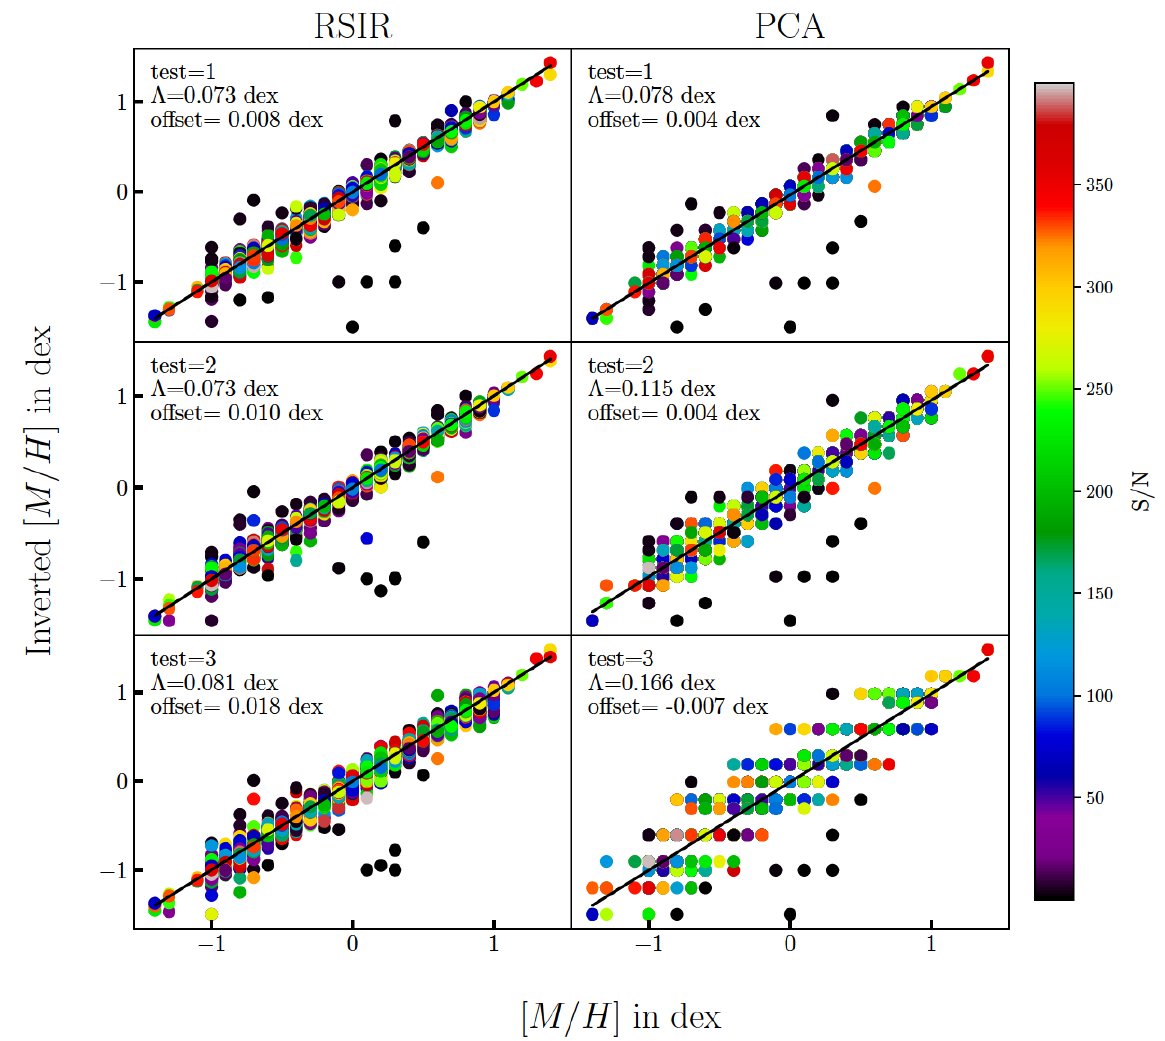
Figure A2. Results of the metallicity inversion for the synthetic A to K